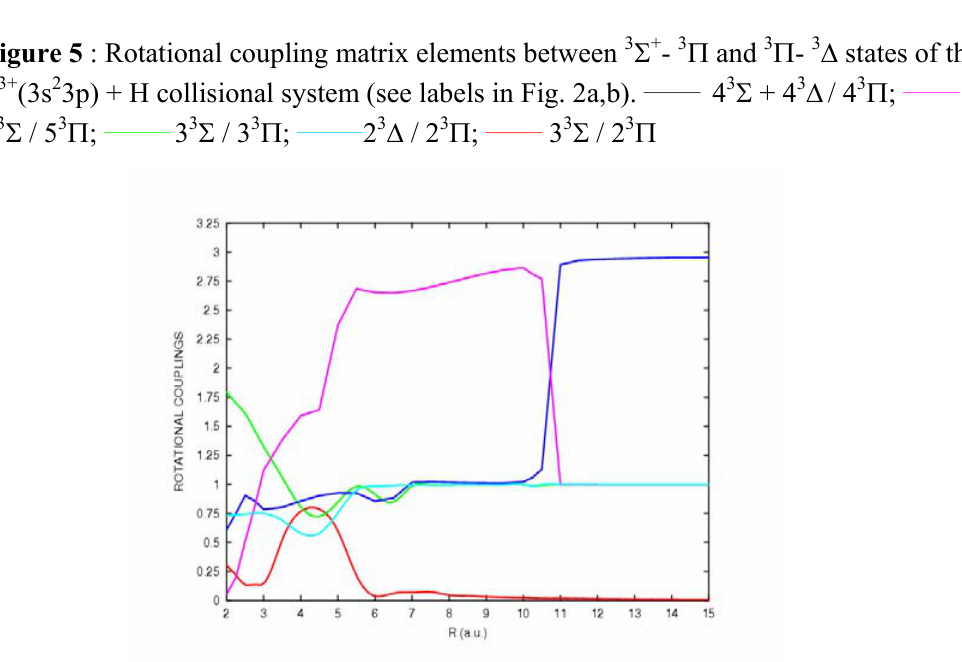
Figure 5 : Rotational coupling matrix elements between 3 Σ + - 3 Π and 3 Π - 3 ∆ states of the S 3+ (3s 2 3p) + H collisional system (see labels in Fig. 2a,b). ______ 4 3 Σ + 4 3 ∆ / 4 3 Π ;